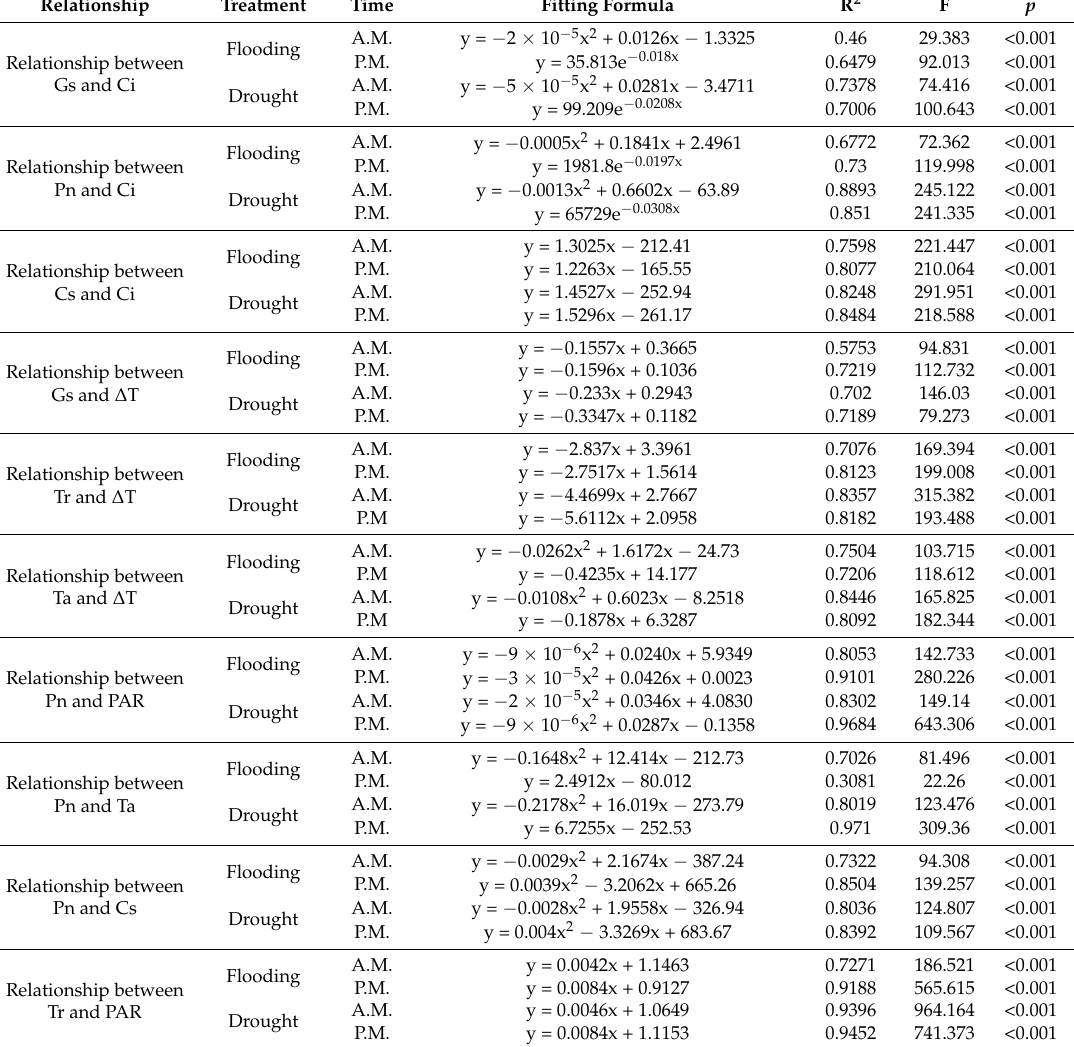
Table 2. Regression analysis between rice physiological indicators and environmental factors under paddy field’s water level